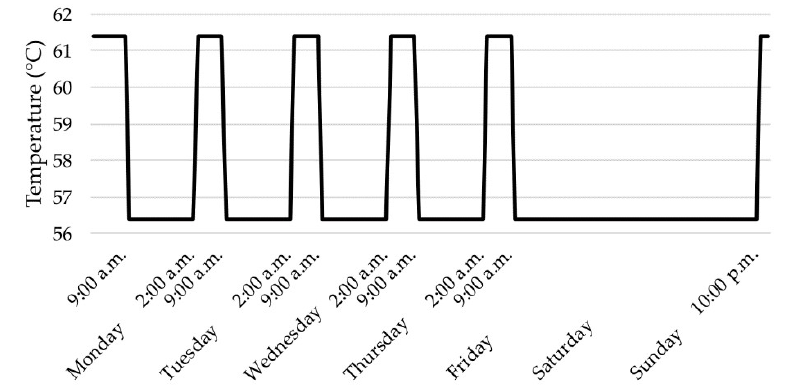
Figure 4. Hydronic radiator supply temperature schedule a week with − 20 ◦ C outdoor temperature.